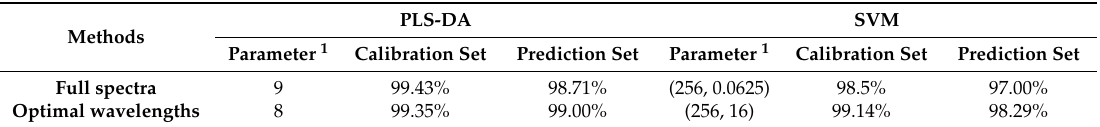
Table 2. Comparison of discrimination ability obtained by different PLS-DA and SVM models, with the total spectral data and optimal wavelengths selected by the competitive adaptive reweighted sampling (CARS)